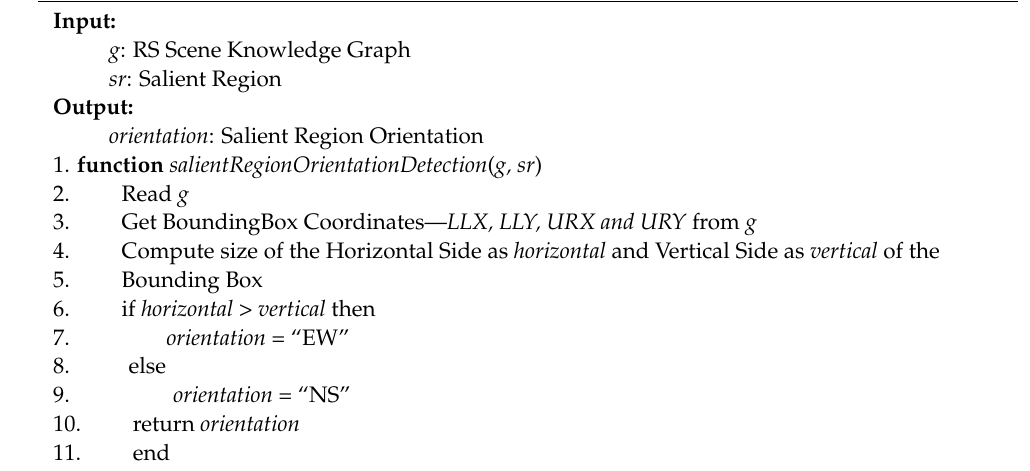
Algorithm 4 Salient Region Orientation